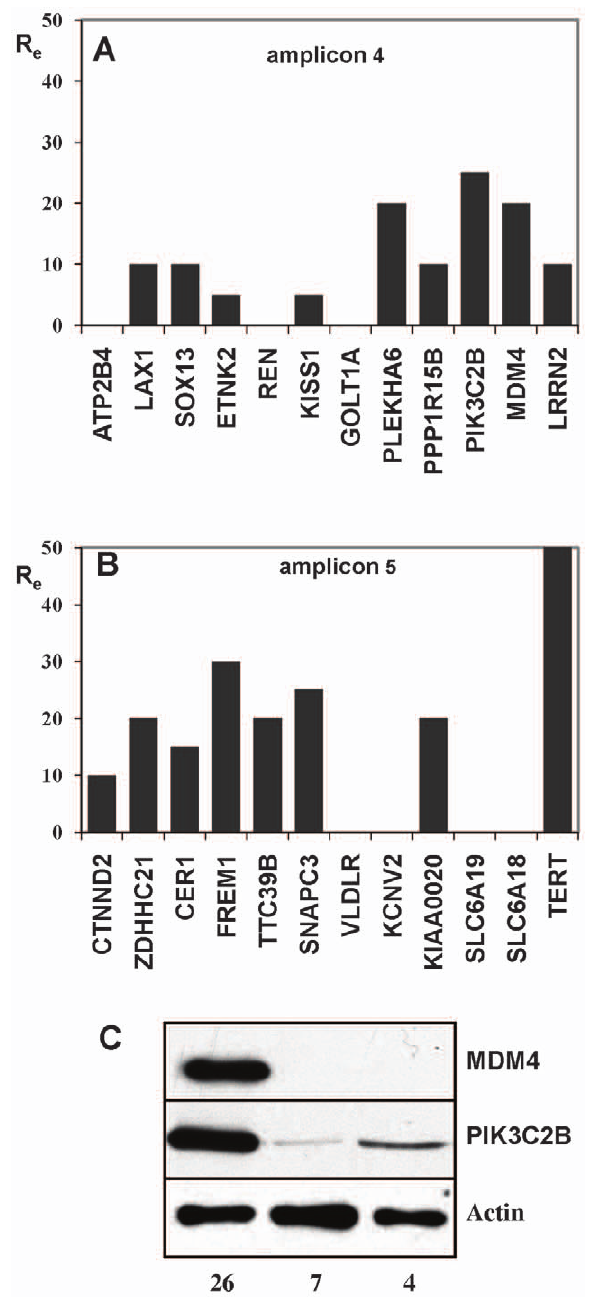
Figure 4. RT-Q-PCR expression of genes amplified in tumour 26. Full-length names of the genes are listed in Supporting Information Table S1. A: Amplicon 4; B: Amplicon 5. Positions of the genes are shown in Supporting Information Fig. S1. The expression ratio (R e ) was calculated by dividing the normalised expression measured in the tumour by the mean of the normalised expressions measured in the reference set of tumours. ATPB4, REN, GOLT1A, VLDLR, KCNV2, SLC6A19 and SLC6A18 are expressed neither in tumour 26 nor in the reference set. C. Western blot probed with the anti-MDM4 and anti-PIK3C2B antibodies for gliomas 26, 7 and 4. Proteins were over-expressed in tumour 26. Actin: loading control. found that the telomeres were shorter in tumour 26 (less than 5 kb) than in two gliomas without TERT amplification, which display normal telomere lengths of 5 to 15 kb (Supplementary data S7).